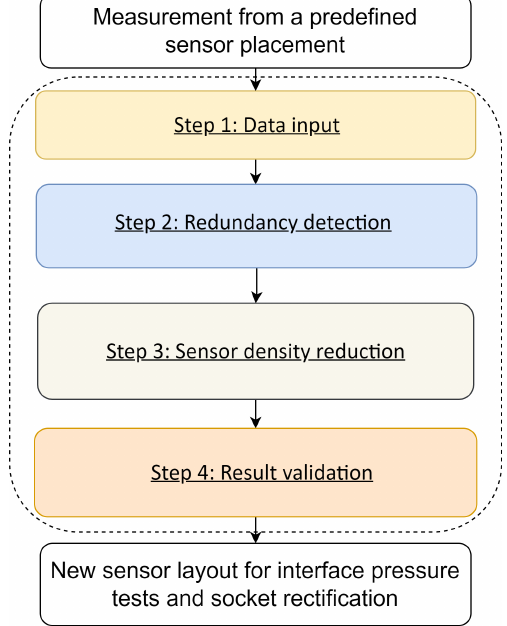
Figure 3. The clustering-based analysis method